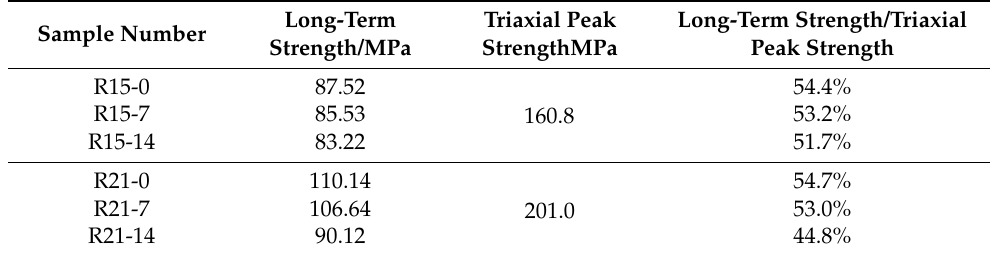
Table 3. Isochronous curve method to determine long-term strength under different